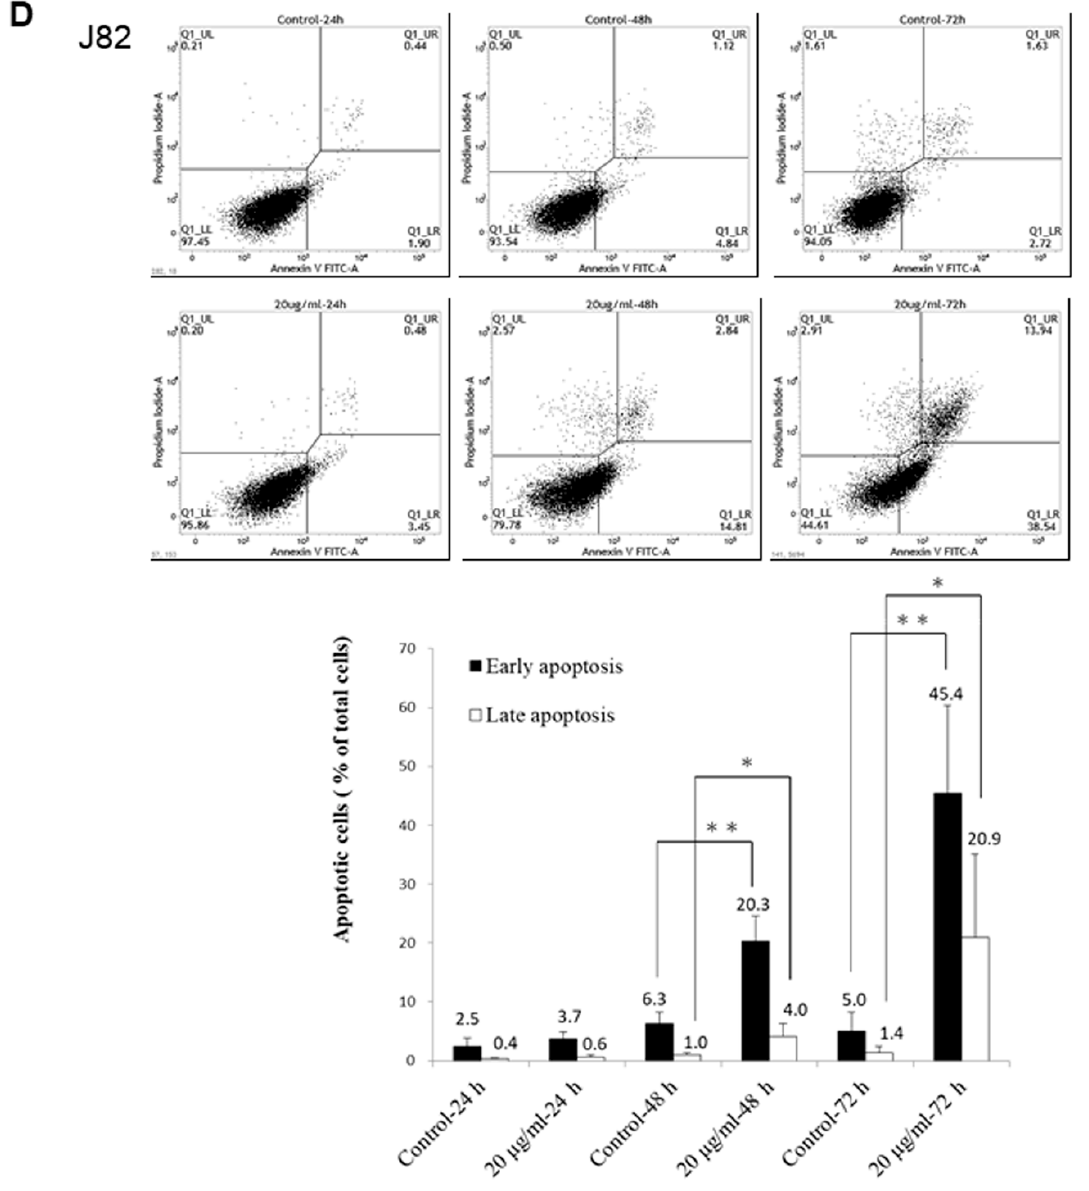
Figure 2. The propidium iodide (PI) and PI/annexin V analyses of UBUC cells treated with PEPE2. The results of PI analyses were represented in ( A ) the T24 cells and ( B ) the J82 cells. The data of the PI/annexin V measurement were shown in ( C ) T24 cells and ( D ) J82 cells. Each flow cytometry figure was the typical result of three independent experiments. The diagram under the PI/annexin V panel was the results of the three independent experiments. The cell cycles and apoptosis detection of the T24 or J82 cells treated with PEPE2 were measured with PI and PI/annexin V analyses, respectively, using flow cytometry as described in the supplementary document. The 0.1% ( v / v ) DMSO-treated UBUC cells were implemented as the vehicle control. * p ≤ 0.05, ** p ≤ 0.01, *** p ≤ 0.001.